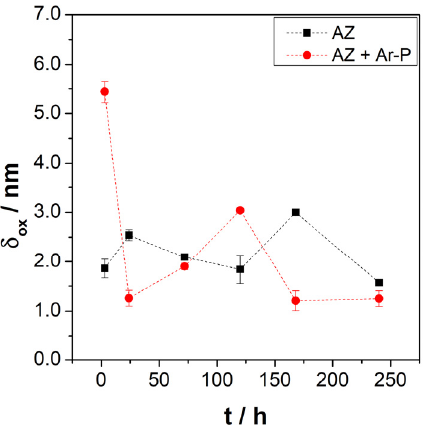
Figure 8. Evolution of the layer thickness ( δ ox ) for the differently pretreated AZ31 alloy immersed in 0.1 M of Na 2 SO 4 .